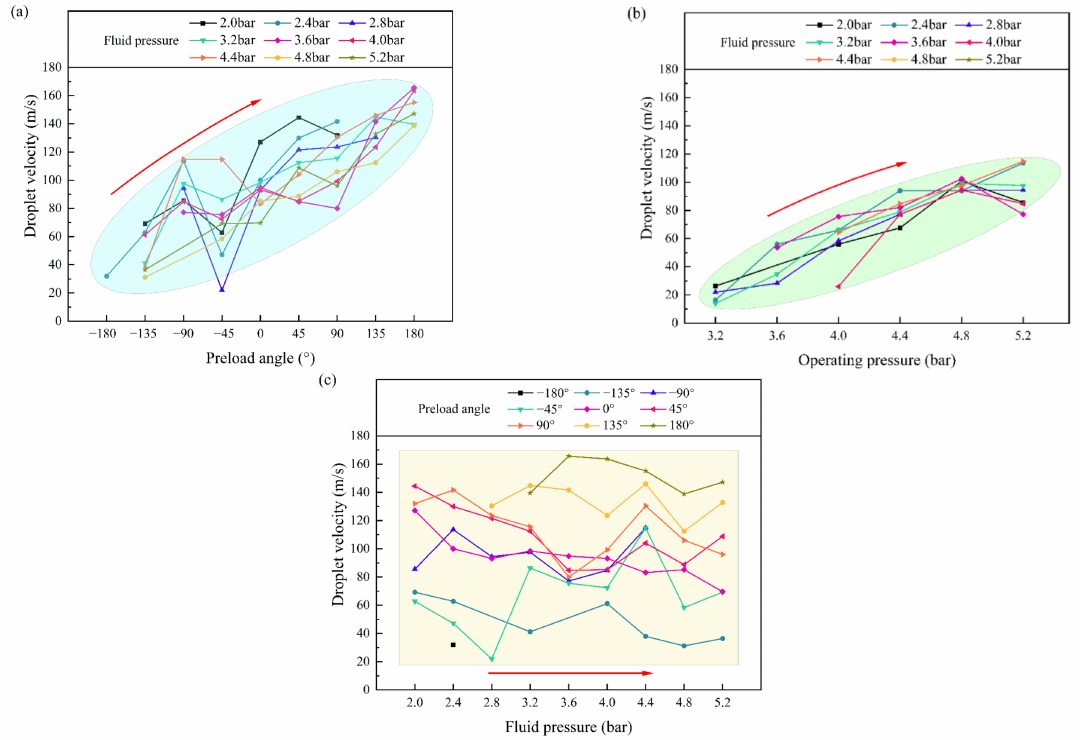
Figure 5. Effect of ( a ) preload angle, ( b ) operating pressure, and ( c ) fluid pressure on drop